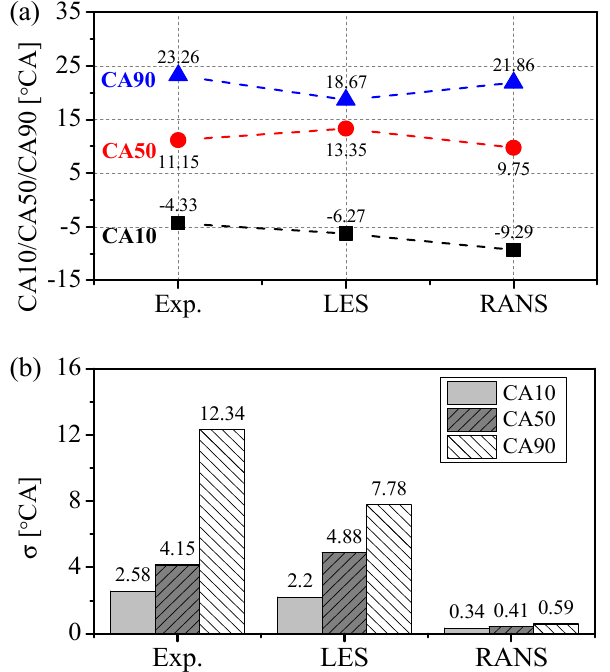
results indicate that the cylinder pressure-based approach shows almost the same results of CAT as the autoignition cells-based approach. Therefore, the pressure-based approach Figure 6. The comparison of ( a ) CA10, CA50 and CA90 and ( b ) corresponding standard deviations was applied to analyze the CAT in both experiments and simulations for consistency. Figure 6. The comparison of ( a ) CA10, CA50 and CA90 and ( b ) corresponding standard deviations ( σ ). ( σ ).